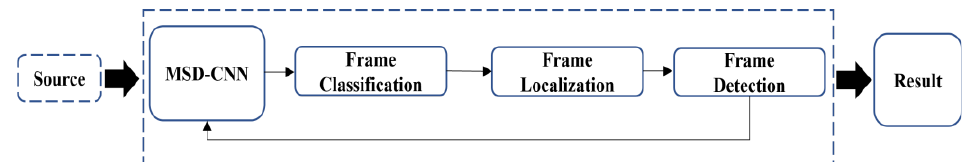
Figure 5. The sequence of the flow of MSD-CNN methodology.